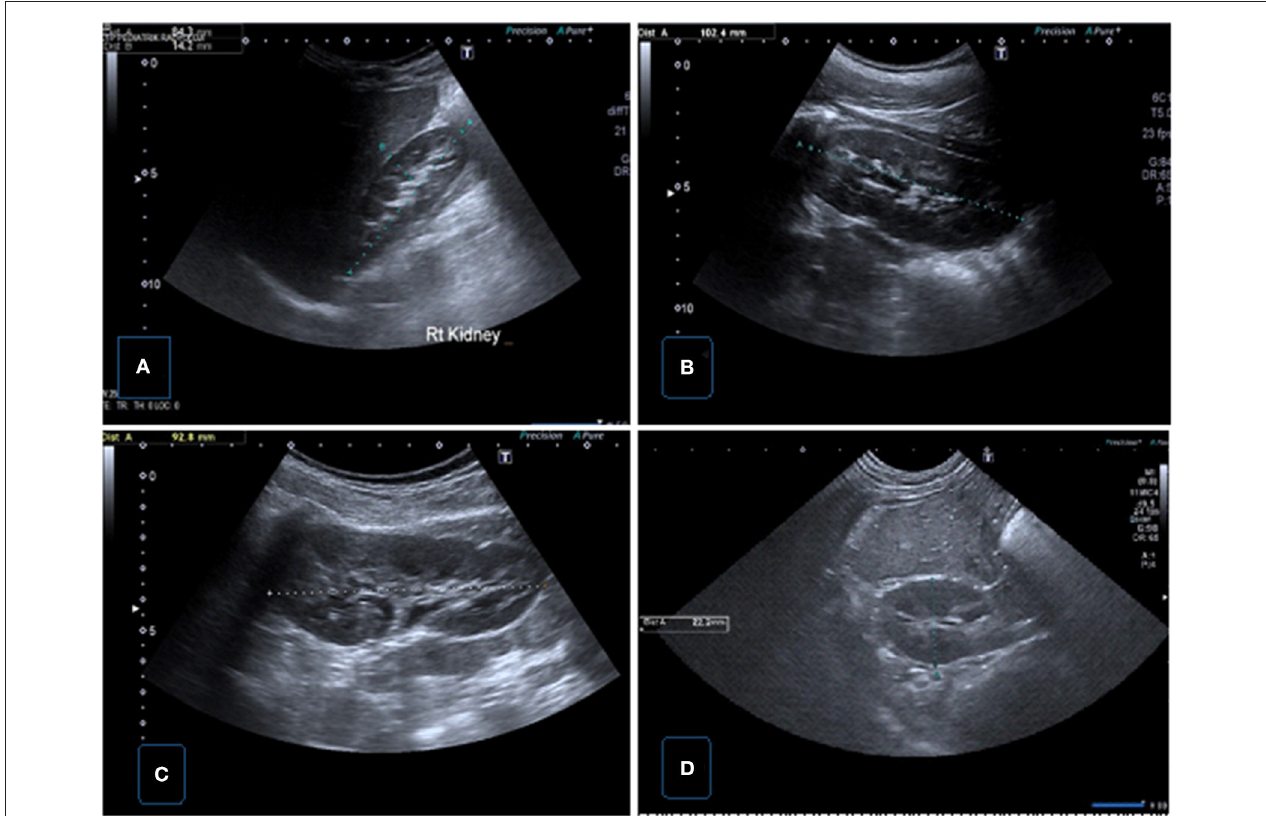
FIGURE 1 | Normal renal sonographic images obtained with convex probes. (A) Longitudinal US image of the right kidney demonstrating renal length and parenchymal thickness in supine position. (B) Longitudinal US image of the left kidney demonstrating renal length in supine position. (C) Longitudinal US image of the left kidney demonstrating renal length in prone position. (D) Transverse US image of the right kidney showing renal AP